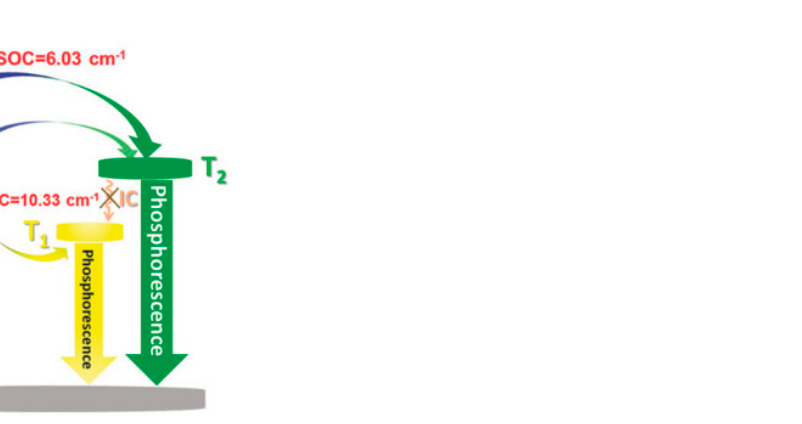
Figure 20. ( a ) Absorption and emission spectra of 82 in THF solution at 298 and 78 K. The insets are the photos of the steady-state emission. The excitation wavelength is 390 nm. ( b ) Natural transition orbital (NTO) images of the S 1 , S 2 , T 1 and T 2 excited states of 82 . The NTO images of each excited state represent their transition forms from the “hole” unity to the “particle” unity, respectively, and the percentages on the arrows are the proportions of the transitions. ( c ) Schematic Jablonski diagram with SOC matrix elements of RTP-related ISC processes in 82 . Adapted with permission from [76].